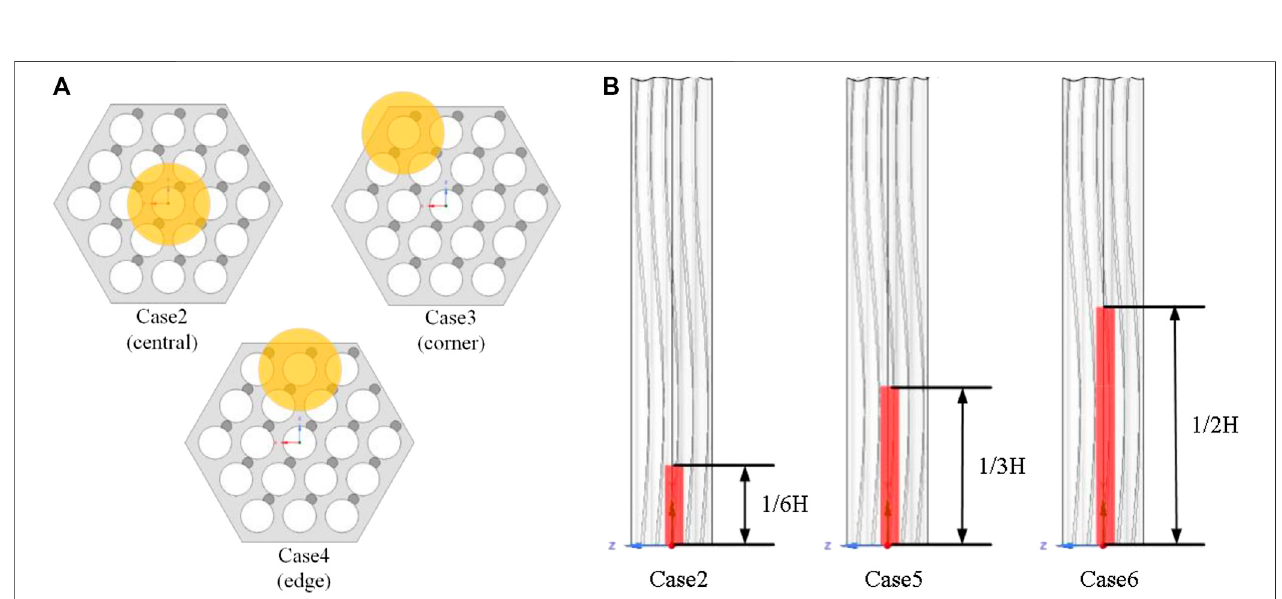
FIGURE8| Theschematic positions and layouts oftheblockagesin thesix cases. (A) Blockages positions incases 2, 3, and 4. (B) Blockage positionsin cases 2, 5, and 6.